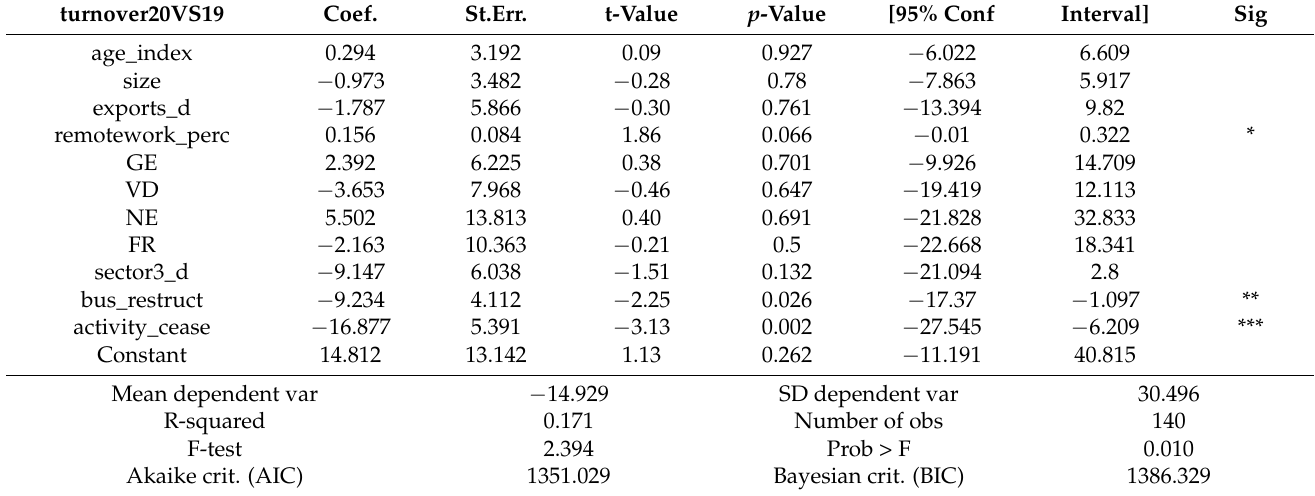
Table 6. Main model results.